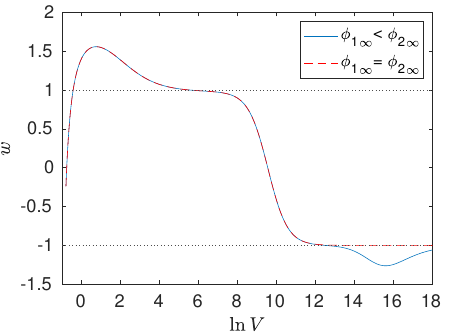
Figure 1. The behaviour of w in the two modes case, where both modes have only one interaction term. The blue solid line shows the case where φ 1 ∞ < φ 2 ∞ , while for the red dashed line, we have φ 1 ∞ = φ 2 ∞ . Two black dotted lines show w = 1 and the phantom divide w = − 1, respectively. The parameters are V = 1/3, m 2 = 3, E = 5, Q 2 = 9, λ = − 10 − 8 , µ = 0, V = 1/2, m 2 = 2, E = 9, Q 2 = 2.25, 2 2 1 1 1 1 2 2 1 1 µ 2 = 0, n 1 = n 2 = 6, and λ 2 = − 9.5 × 10 − 8 for φ 1 ∞ < φ 2 ∞ , while λ 2 = − 9.5725 × 10 − 8 for φ 1 ∞ = φ 2 ∞